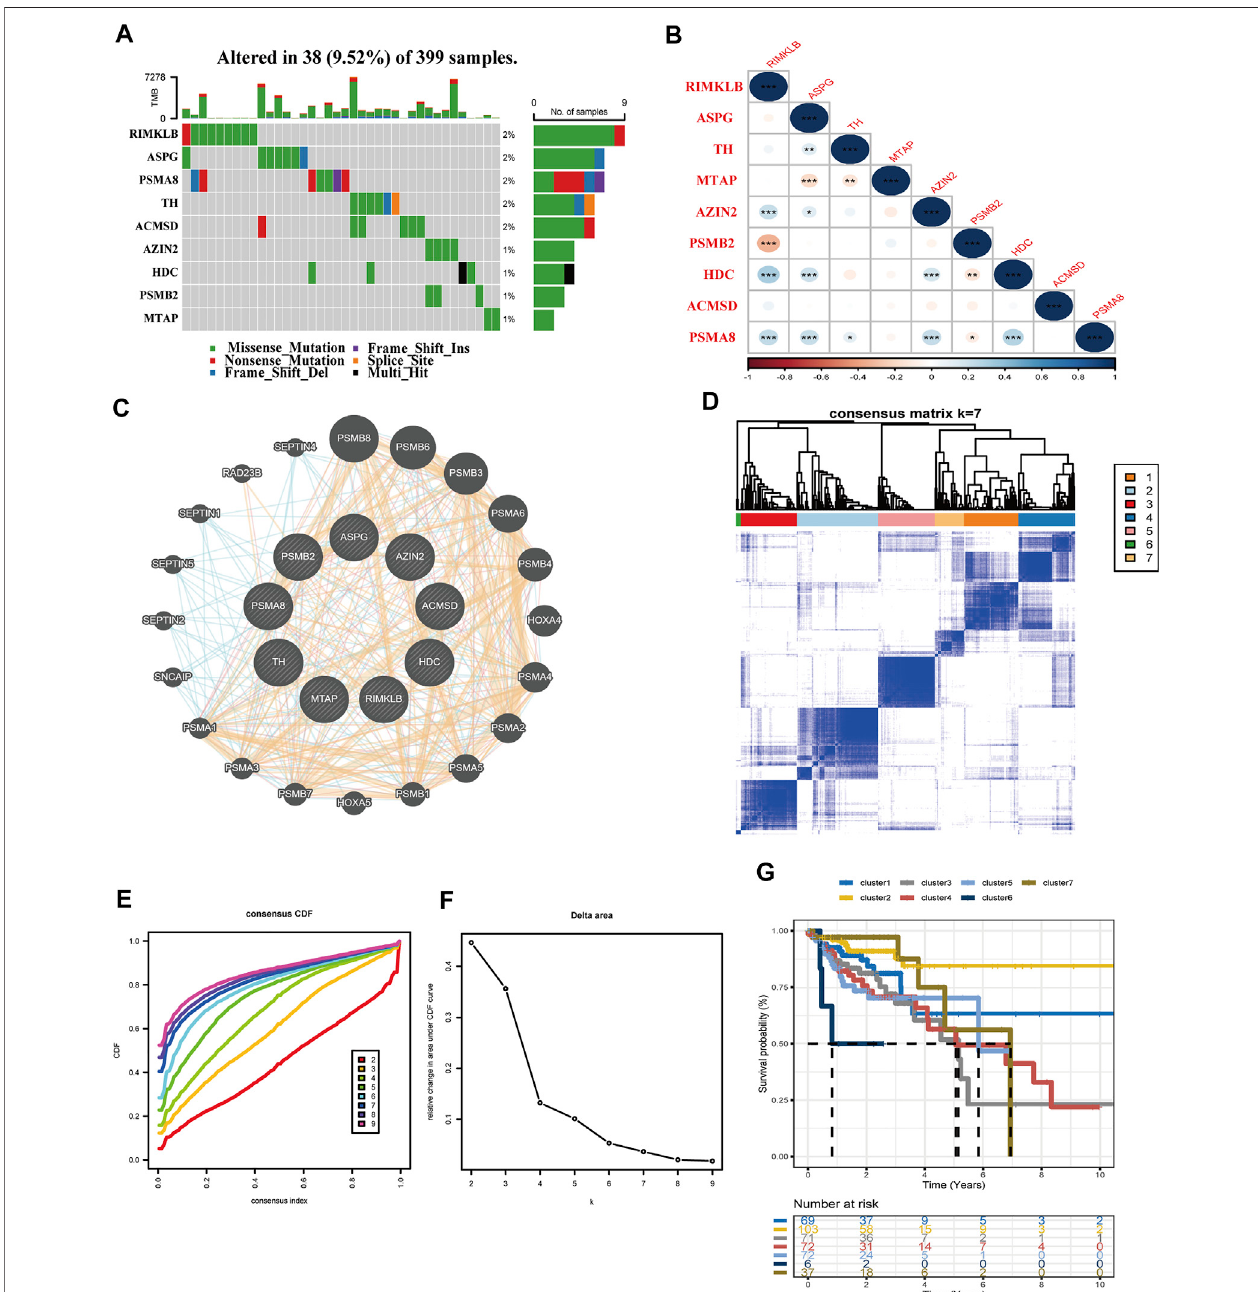
FIGURE 7 | Interrelationships of nine genes involved in the amino acid metabolism. (A) TMB analysis of the nine genes in 399 samples of TCGA-COAD. (B) Spearman correlation analysis of the nine genes (*** p < 0.001, ** p < 0.01, * p < 0.05). (C) Protein interaction network analysis. (D – F) Consensus cluster analysis divides the gene signature into seven categories. (G) Validation of the seven clusters in the K – M